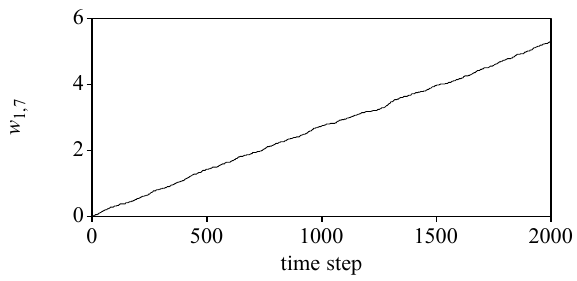
Figure 7: The development of a weight in pure Hebbian learning: linear and without